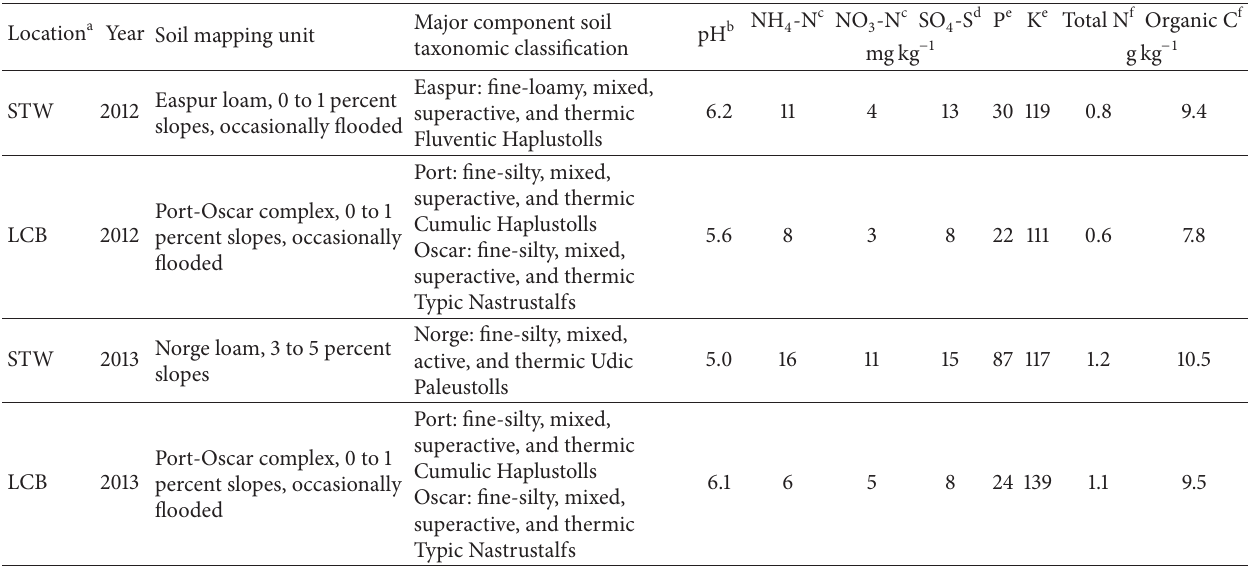
Table 1: Preplant surface (0–15cm) chemical characteristics and soil classification of sites utilized in this study. Location a Year Soil mapping